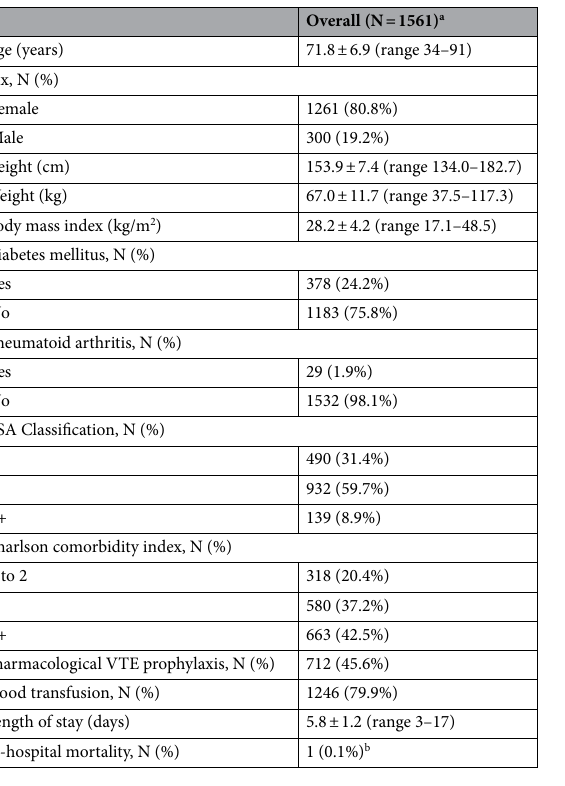
Table 1. Patient demographics. ASA: American Society of Anesthesiologists; VTE: venous thromboembolism. a Percentages may not add up to exactly 100% due to rounding. b Reason of in-hospital mortality: ischemic bowel